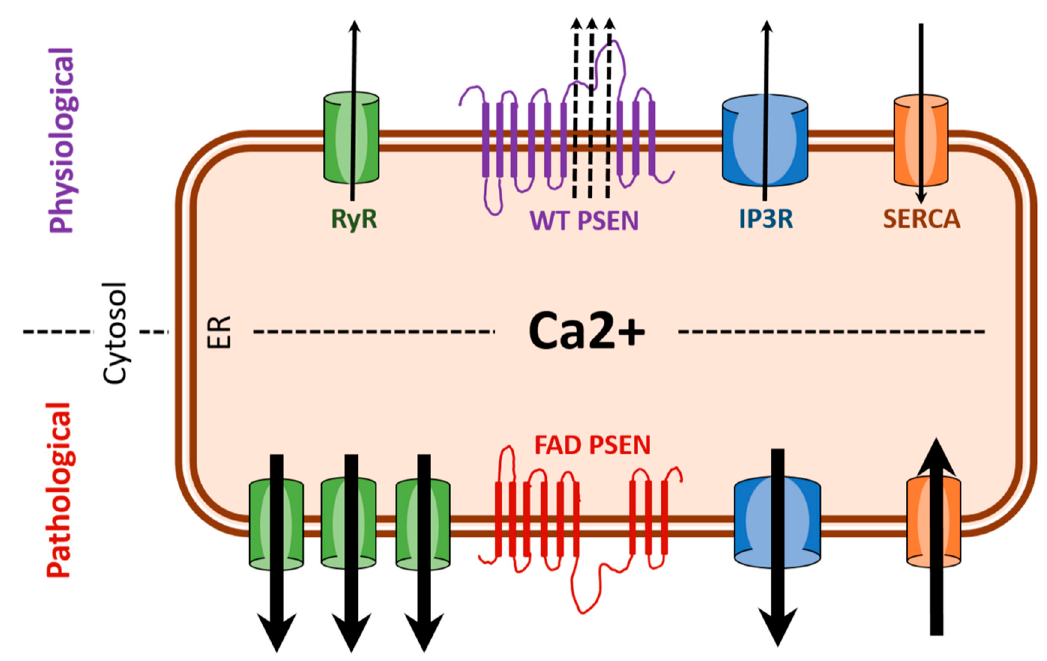
Figure 1. FAD (familial Alzheimer’s disease) presenilin mutations result in enhanced ER (endoplasmic reticulum) calcium release. Under pathological condition associated with FAD, there is excessive ER (calcium release) as a result of overexpression of RYR (ryanodine receptors) and potentiation of IP3R (IP3 receptors). Also, hyperactivity of SERCA (sarco/endoplasmic reticulum calcium ATPase) pumps and the loss of leak channel function of PSEN (presenilin) can increase ER-calcium stores thereby increasing release of calcium via RYR and IP3R. Black arrows indicate direction of calcium movement.